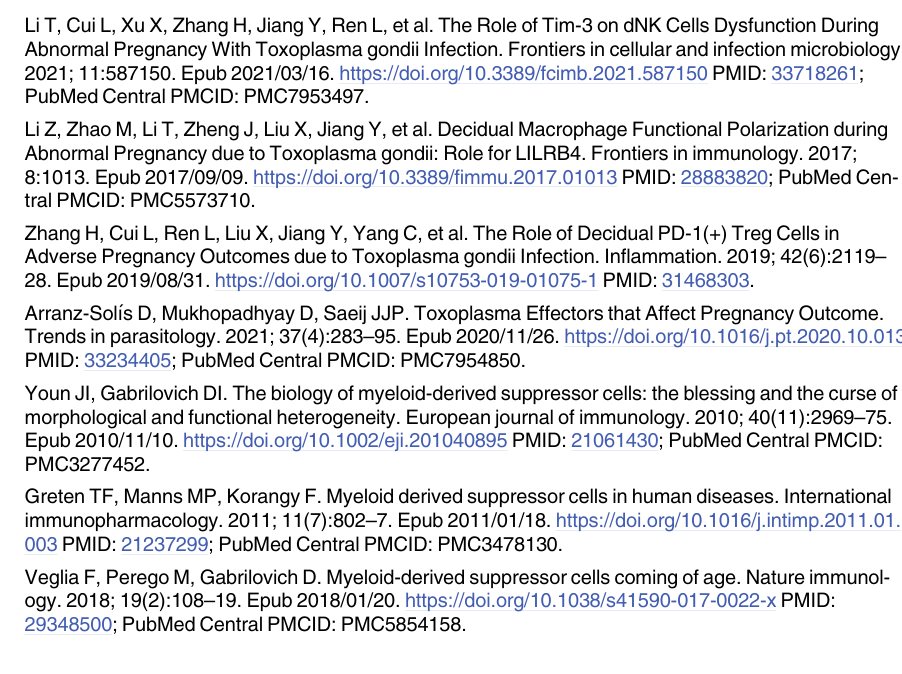
S1 Table. Reagents and antibodies used in this